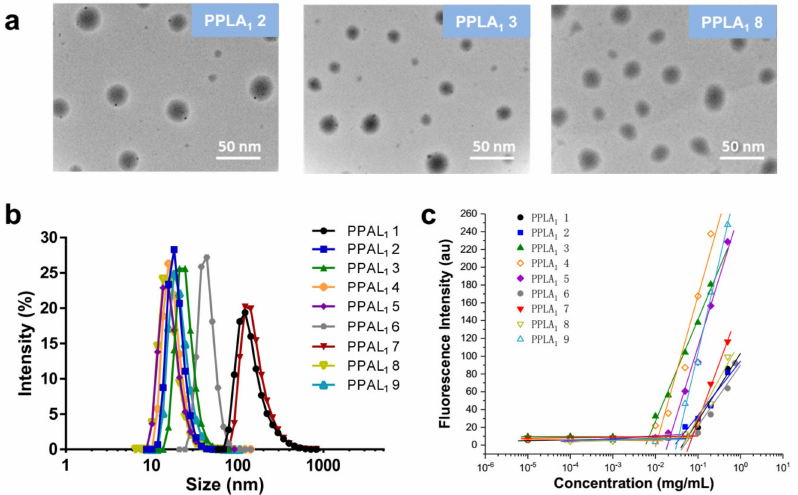
Figure 4. Characterization of related nanoparticles. TEM images of PPLA 1 2 , PPLA 1 3 and PPLA 1 8 nanoparticles ( a ). Dynamic light scattering curves of PPAL 1 1-9 nanoparticles in aqueous media ( b ) and determination of the CMC of PPAL 1 1–9 copolymers ( c